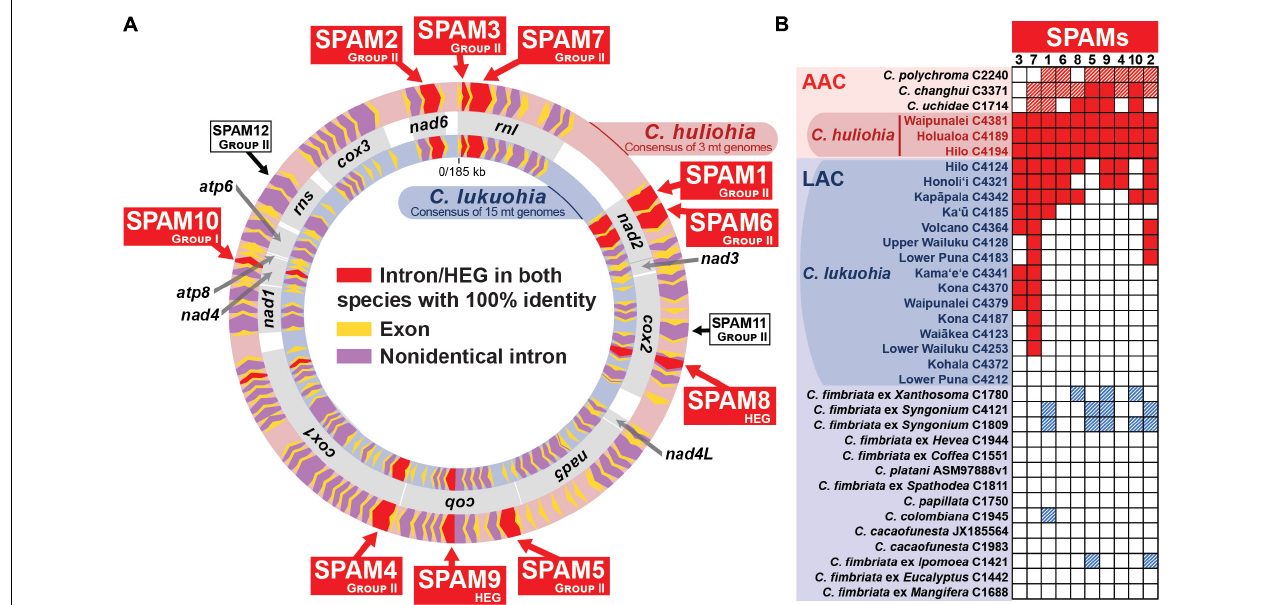
FIGURE 2 | Ten “SPAM” (SPecies A Mitochondrial) elements heterogenous among Ceratocystis lukuohia genomes but identical and always present in Ceratocystis huliohia . (A) Mitochondrial genome maps for C. lukuohia and C. huliohia , with SPAMs putatively transferred from the Asian C. huliohia (outer circle) to the Latin American C. lukuohia (inner circle) indicated as red chevrons and named with red boxes. The red-shaded c ox1 i17 (near the end of cox1 ) was found with 100% identity in both species but was also present with 100% identity in nearly all the studied genomes. White boxes indicate two putative SPAMs that were not found in studied C. lukuohia isolates. Mitochondrial genes are indicated by gray boxes between the genome maps and named in bold. (B) The presence and absence of SPAM mobile elements in mitogenomes of C. lukuohia , C. huliohia and other Ceratocystis species. Solid red boxes indicate present orthologs with 100% identity to the region in C. huliohia ; red hashed boxes indicate an Asian-Australian Clade ortholog with less than 100% identity; blue hashed boxes indicate a Latin American Clade ortholog with less than 100% identity; white boxes indicate absence.